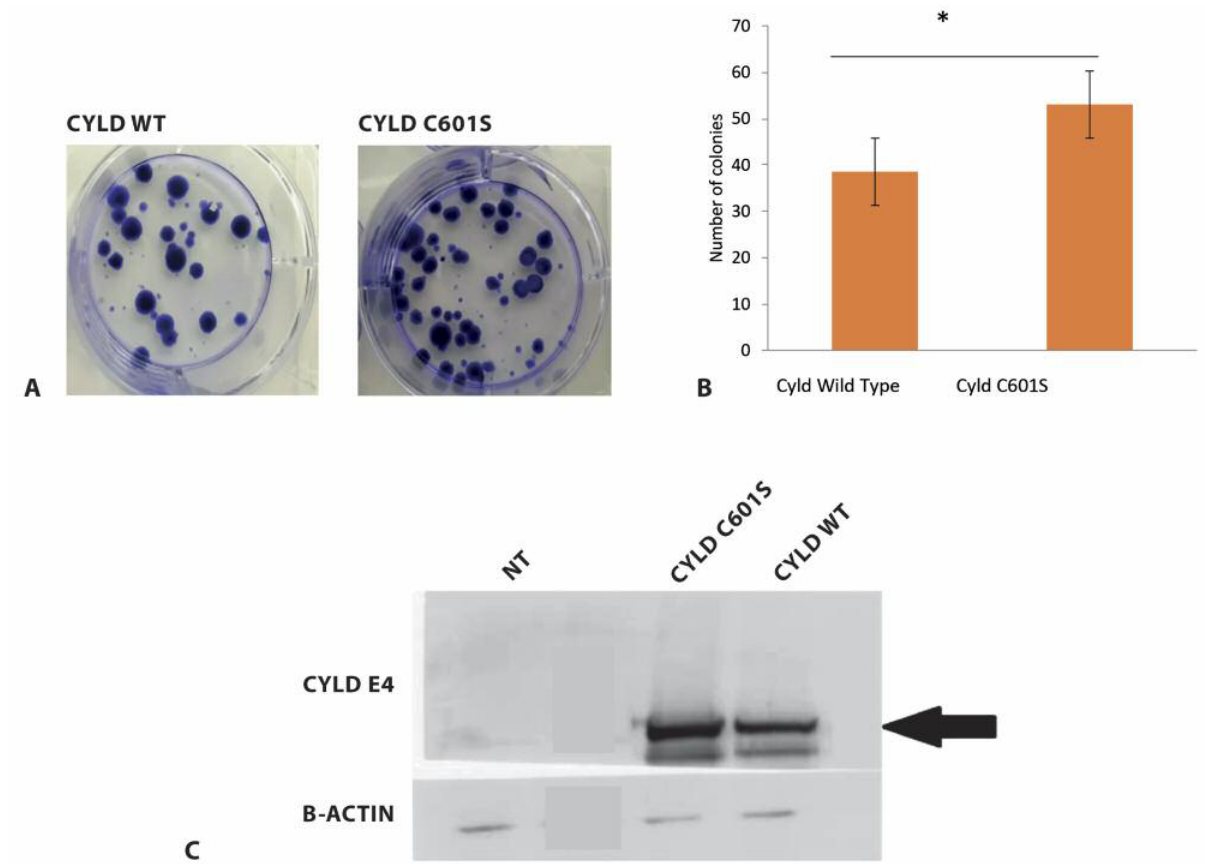
Figure 3. Clonogenic assay to evaluate the e ff ect of CYLD wt and mutant CYLD C601S on the viability of an embryonic kidney cell line. HEK293T cells were transfected with plasmids expressing CYLD wt, and CYLD C601S. Twenty-four hours post transfection cells expressing CYLD wt or the catalytically inactive CYLD mutant C601S were counted and seeded in 6 wells plates and cultured for 10 days in the presence of 0.5 mg ml –1 G418. (A) Representative pictures of cells clones that were scored. (B) Mean values of colony number (+/–SE) from three independent experiments are shown. Statistical evaluation was performed using student’s t-test (* p < 0.05). (C) Detection of CYLD wt and CYLD C601S proteins in HEK293T cells. Whole cell lysates of HEK293T cells transfected with CYLD wt or CYLD C601S expression vectors in A were isolated twenty-four-hour post transfection and analyzed for the expression of CYLD and actin proteins by